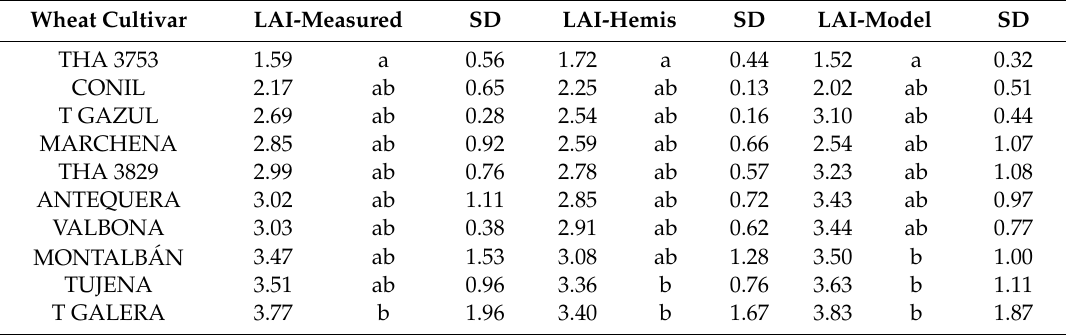
Table 4. LAI values determined for ten wheat cultivars with the direct and the two indirect methods assessed in this study during DaS = 58 (2 February 2019).